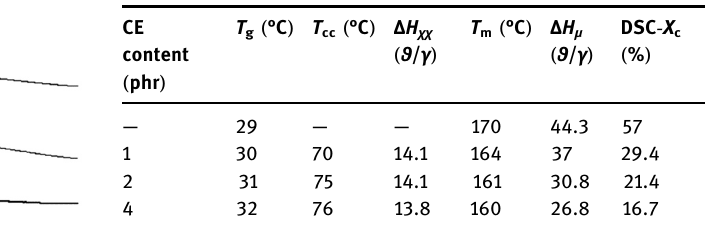
Table 2: DSC results from heating scans of in situ chain - extended PLLA - PEG - PLLA